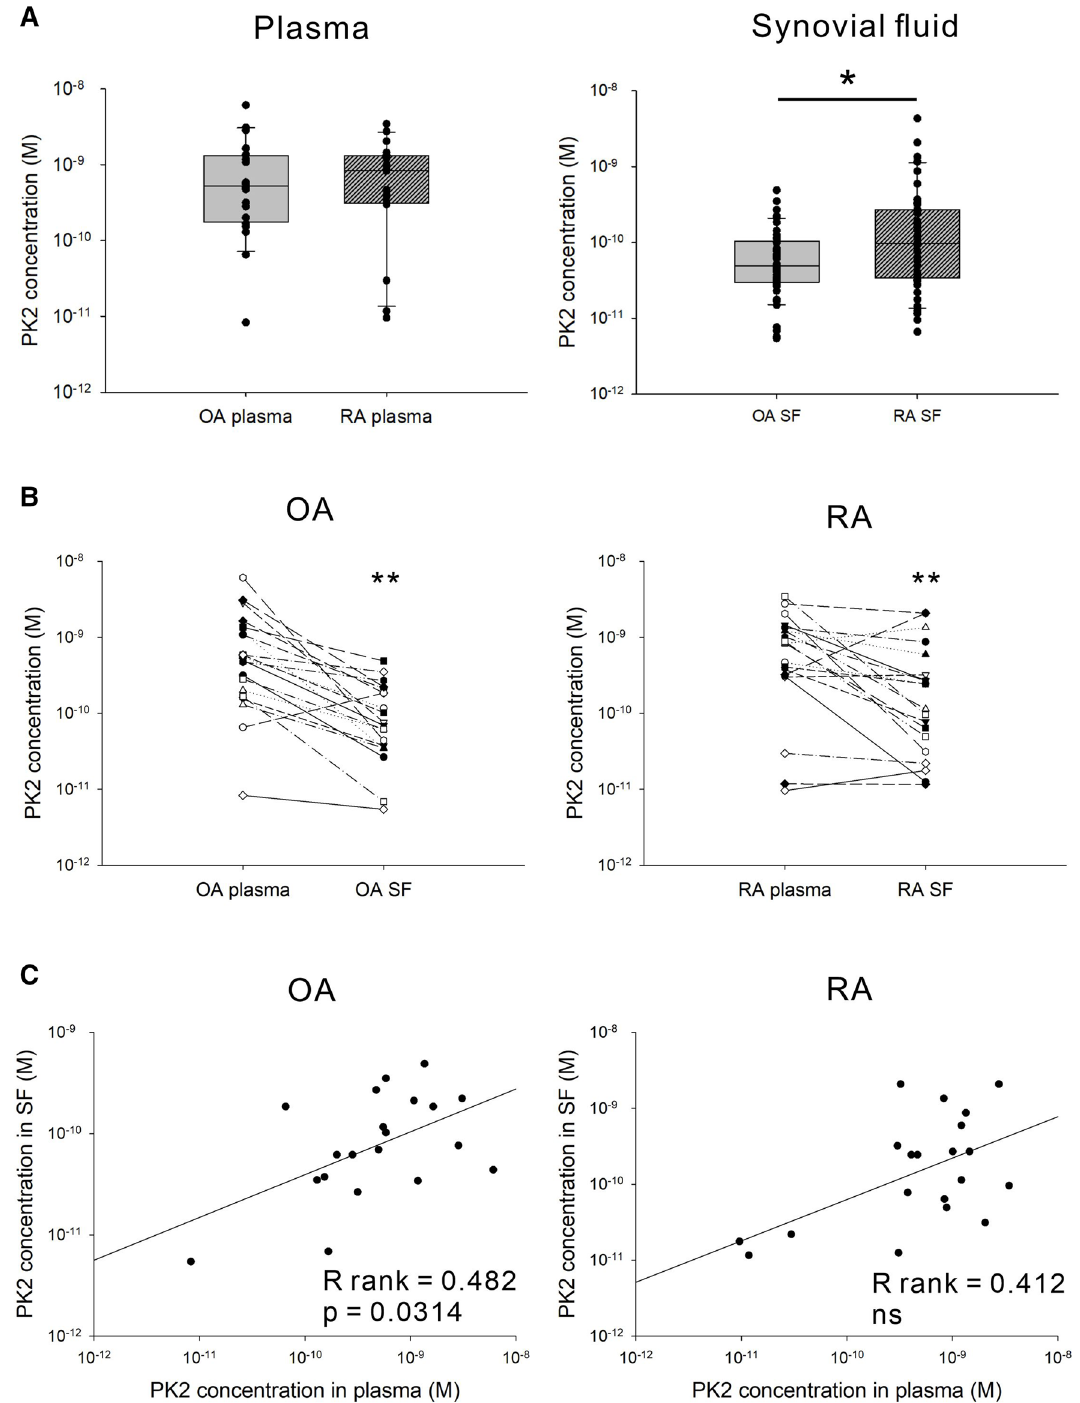
Figure 5. The PK2 concentration in plasma and synovial fluid from OA and RA patients. ( A ) Comparison of plasma (N = 20) and synovial fluid (N = 50) PK2 concentrations between OA and RA patients. Data were presented as box plots, the description of which is given in the legend to Fig. 2. For statistical analysis, the Mann–Whitney test was used. *p < 0.05, **p < 0.01. ( B ) Comparison of PK2 concentrations between plasma and synovial fluid in OA and RA patients. N = 20. For statistical analysis, the Wilcoxon signed-rank test was used. ( C ) Correlation of PK2 concentrations between plasma and synovial fluid in OA and RA patients. N = 20. The linear regression line, Spearman rank correlation coefficient (R rank), and respective p-value are given. PK2 prokineticin 2, SF synovial fluid, OA osteoarthritis, RA rheumatoid arthritis, NS not